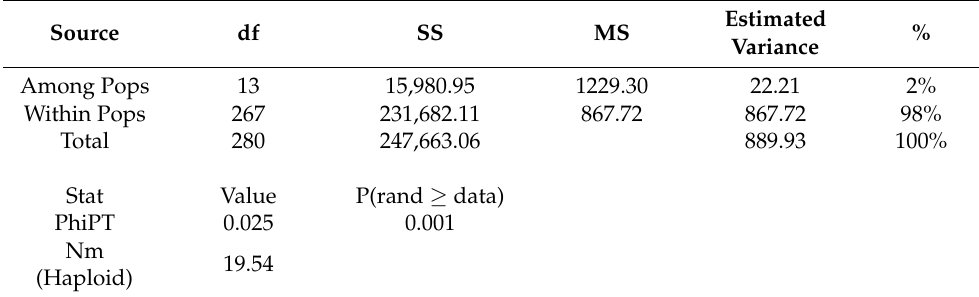
Estimated % Variance